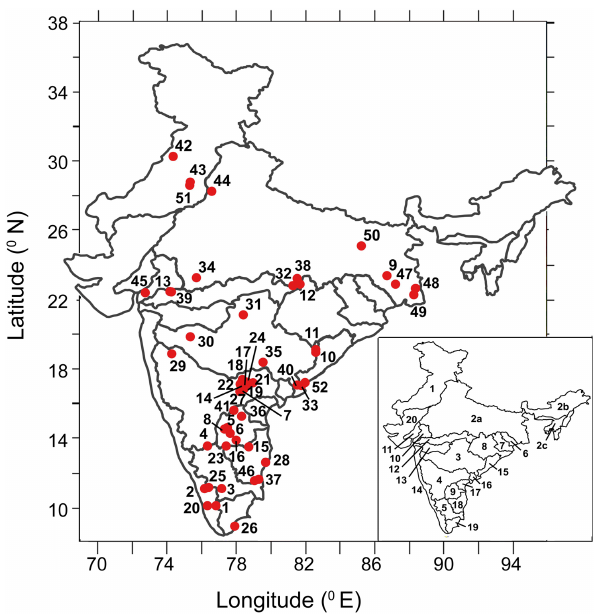
Figure 1. Map of India showing the 22 major river basins and loca- tions (circles) of 52 field-scale recharge measurements used in this study, which were derived from the tritium injection; numbers be- side these locations correspond to sites reported in Table 1. River basin numbers are shown in inset. Field-scale recharge data are taken from the following studies and unpublished estimates: Goel et al. (1975), Athavale et al. (1998, 1992), Rangarajan and Athavale (2000), Bhandari et al. (1982) and Rangarajan et al. (1995, 1997, 1998,